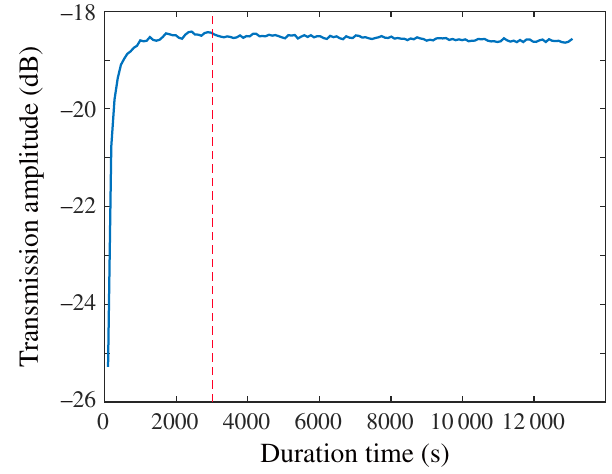
FIG. 7. The transmission amplitude versus the duration time of the drive tone. The s = 0 subensemble is tuned to be in reso- nance with the resonator mode. We resonantly pump the s = 0 subensemble with a drive tone and measure the transmission amplitude at 3.090 GHz. To measure the transmission spectra in our experiment, the duration time of the drive tone is chosen to be 3000 s before each measurement of the transmission amplitude is implemented.